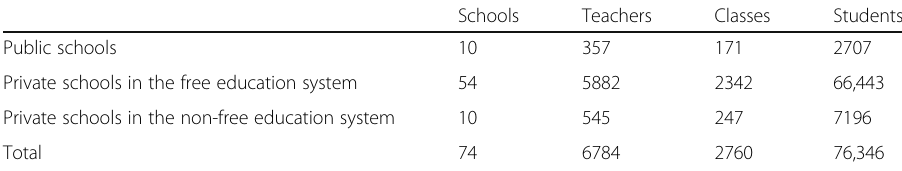
Table 1 The basic information of the schooling system of Macau (Source: DSEJ, 2019) Schools Teachers Classes